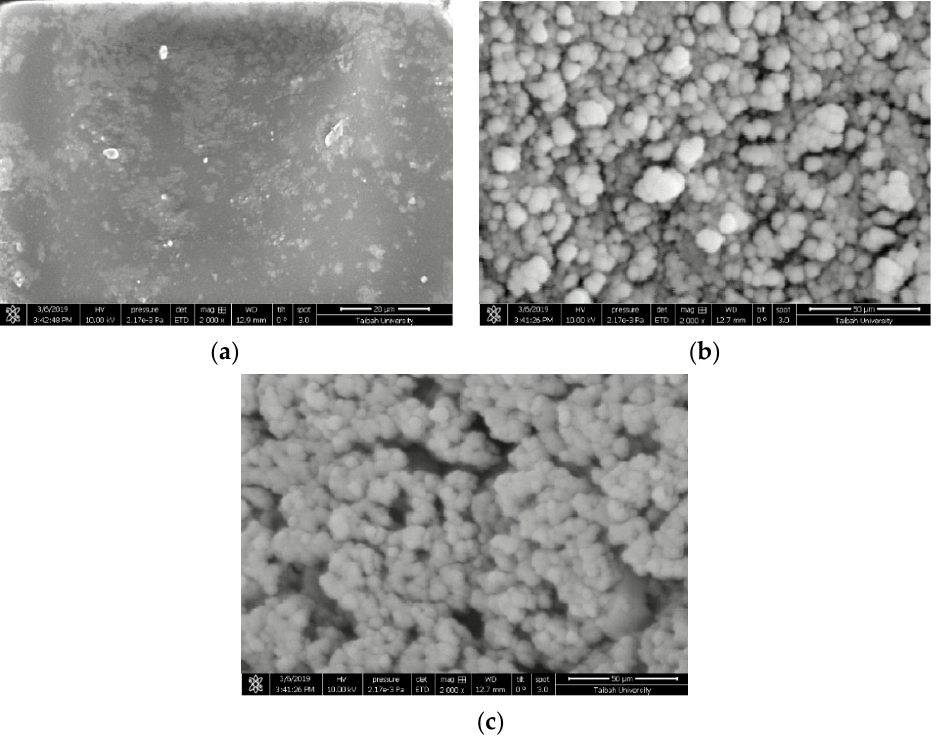
Figure 3. ( a ) SEM image of PVA; ( b ) SEM image of Al 2 O 3 nanoparticles; and ( c ) SEM image of PVA / A 2 O 3